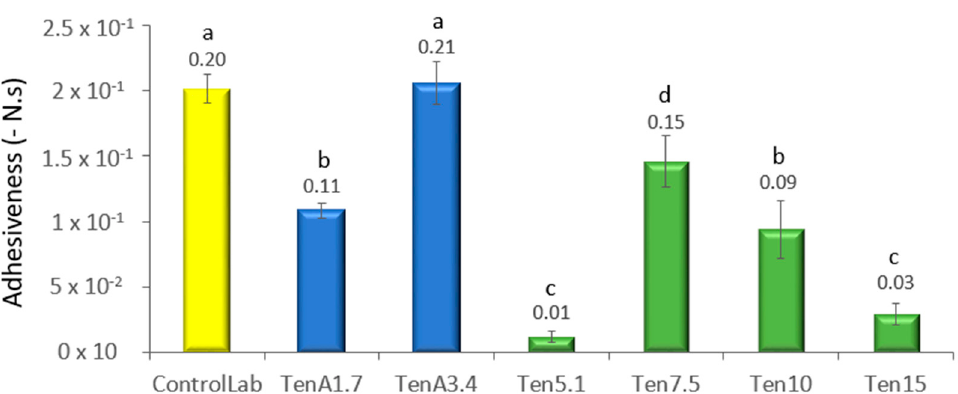
Figure 5. Adhesiveness of the different emulsions (-N.s): gray—standard, blue—samples without egg, but with starch, green—samples without egg and starch. The different lower case letters (a, b, c and d) located above each bar represent the significant difference between the formulations ( p ≤ 0.05), according to the ANOVA calculation.